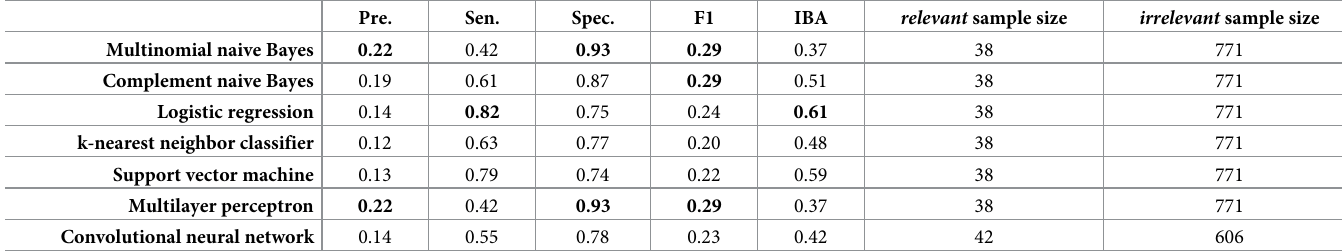
Table 3. The performance evaluation of the relevance classification.